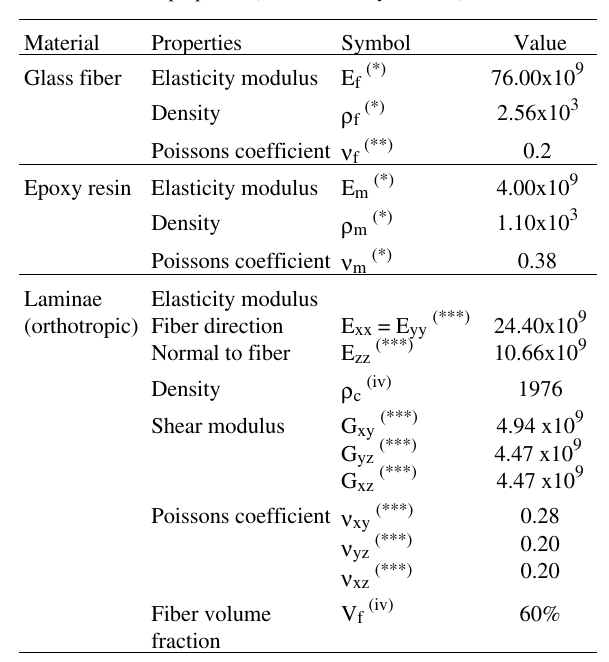
Table 1. Material properties (International System - SI).